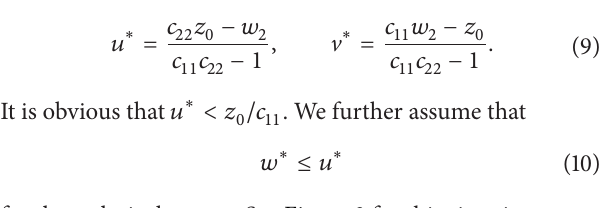
wavefront is a traveling wave solution (𝜙(𝑠), 𝜑(𝑠)) which has finite limits (𝜙(±∞), 𝜑(±∞)) . Denoting the traveling